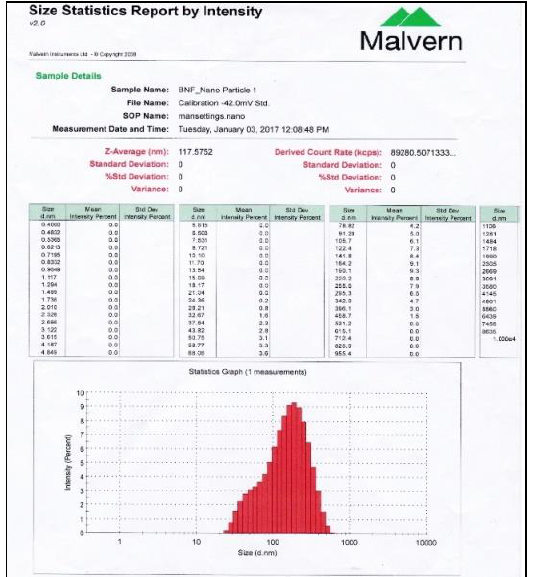
Figure A1. Size Statics Report of nano cellulose by Intensity.